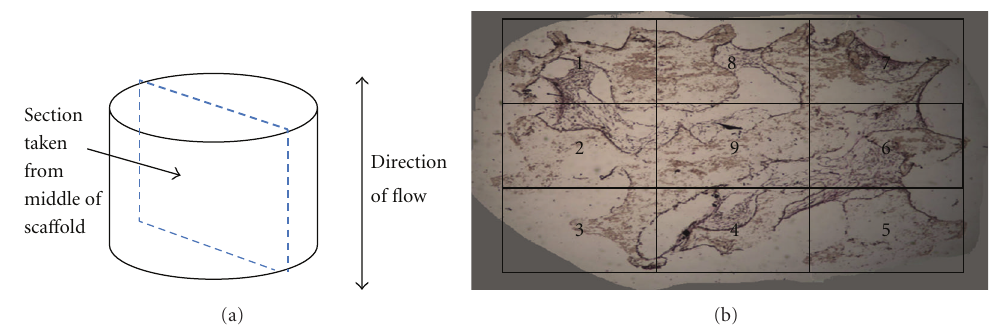
Figure 2: (a) Sections were removed from the middle of the sca ff old parallel to the direction of flow. Nine sample regions from each section were used to quantify cell number, surface coverage, and cell/matrix area coverage. (b) Regions 1–8 are combined and are referred to as the sca ff old perimeter. Region 9 is referred to as the sca ff old